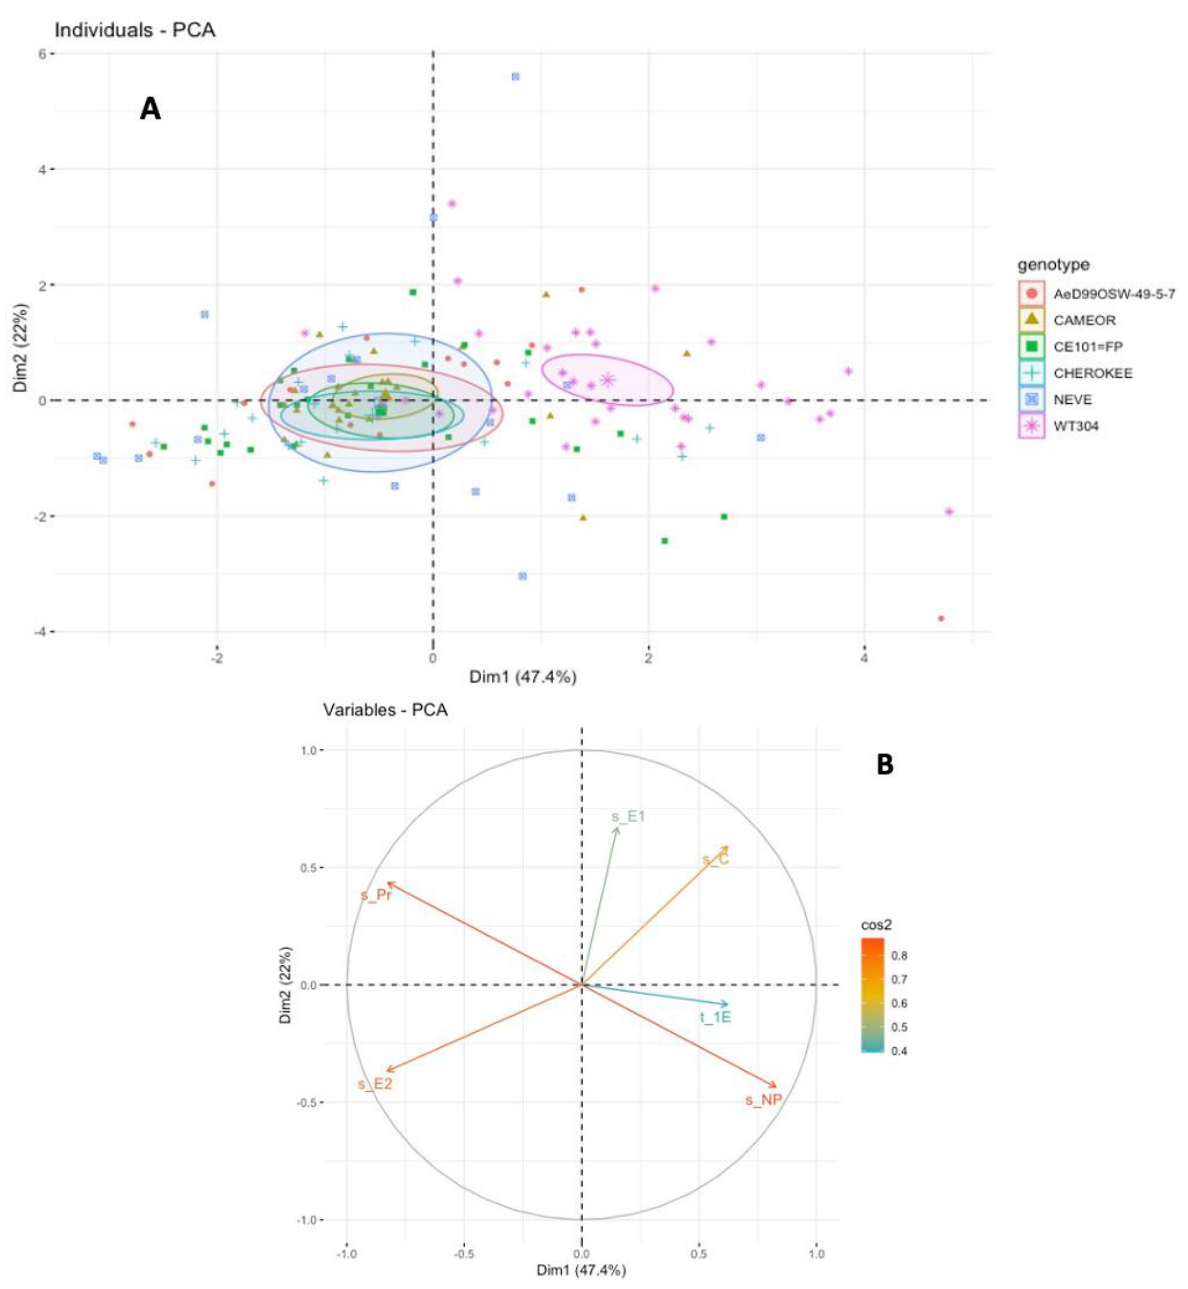
Figure 3. Principal component analysis (PCA) for the aphid trophic behavior by EPG study. Indi- viduals factor map indicating the scores of aphids A. pisum feeding on six Pisum genotypes. The circles show the confidence ellipses (with a confidence level of 0.95) calculated with the barycenter of individuals for each parameter on the factorial plan. ( A ) PCA of individuals of pea biotype (ArPo28) probing on Pisum genotypes, ( B ) Variables factor map indicates the spatial ordination using five parameters: s_NP, total non-probing duration; s_C, total pathway phase; s_Pr, total probing duration; s_E1 total salivation duration; s_E2, total phloem ingestion duration; and t > 1 E, time to first phloem phase.